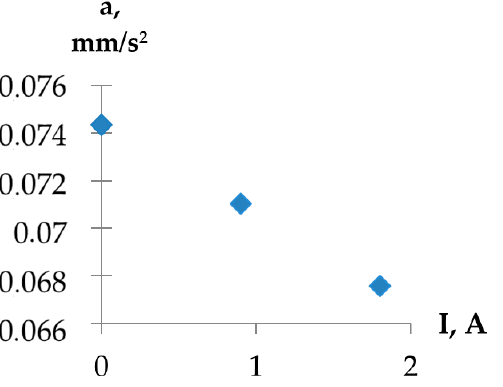
Figure 5. Dependence of the acceleration of the droplet movement on the change in the current applied to the solenoid.